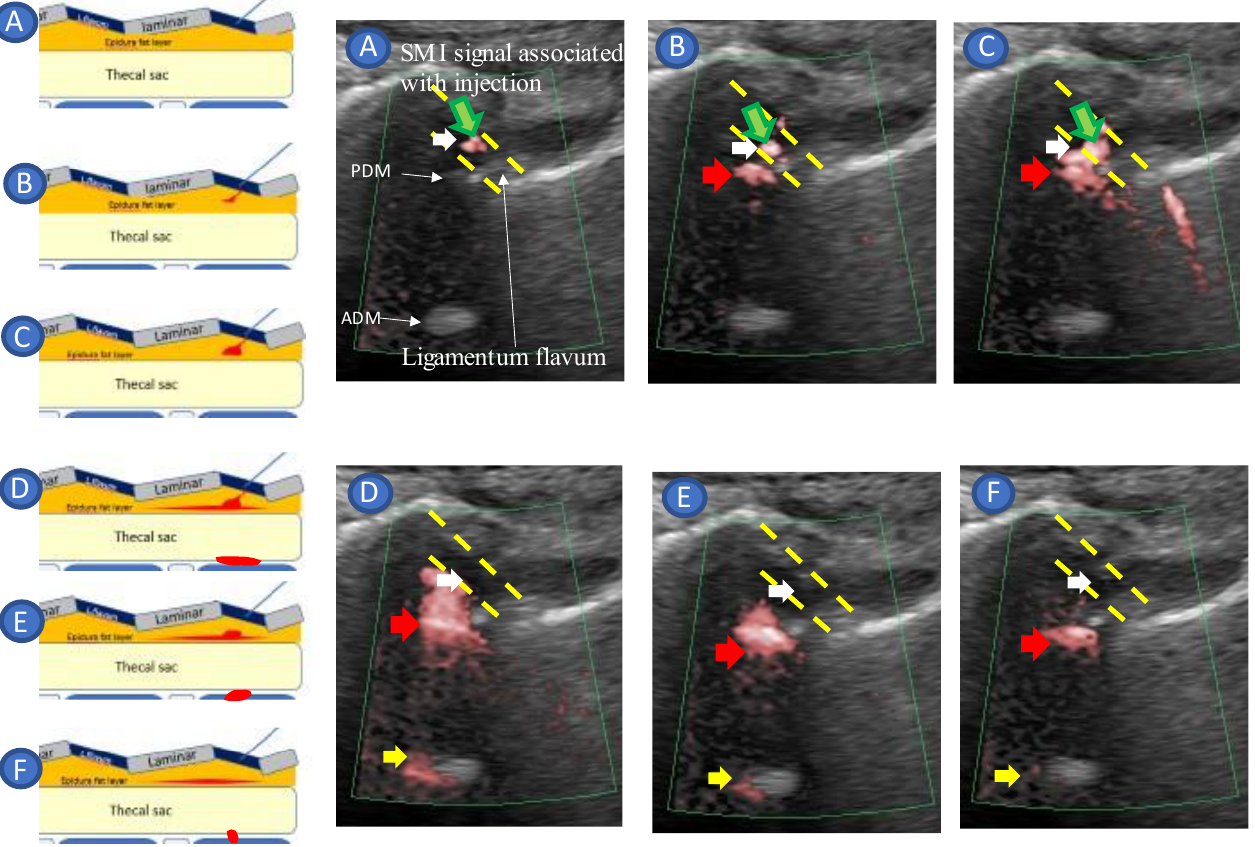
Figure 5. Paramedian sagittal oblique view (rotated by 20 ◦ ) of the lumbar spine during real-time US-guided epidural injection. The inset shows the orientation of the transducer and the direction of the needle in which the Cathelin needle was introduced (in-plane) during the epidural injection. The Cathelin needle tip (white arrows) was embedded in the ligamentum flavum which was confirmed by observing the monitor before changing to SMI mode and by the ligamentous resistance tactile sensation transmitted to the syringe; the green arrow indicates the SMI signal in the ligamentum flavum associated with injection. The yellow dotted line represents the outline of the ligamentum flavum ( A ). When the ligamentum flavum ruptured and the SMI signal indicated by the red arrow appeared in the epidural fat layer ( B , C ), needle advancement was stopped, and the remaining injectant was injected. The SMI signal spread to the posterior indicated by the red arrow and anterior epidural spaces indicated by the yellow arrow ( D , E ). The SMI signal was localized in the posterior epidural space ( F ). While injecting the injectant, the SMI signal was monitored in the epidural space until the drug infusion was completed. Abbreviations: ADM, anterior dura mater; PDM, posterior dura mater; L.flavum, ligamentum flavum.